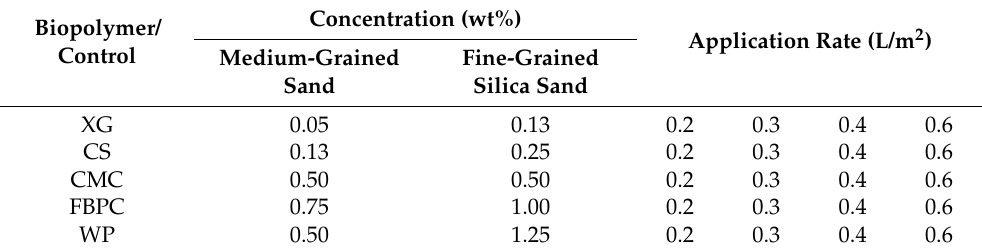
Table 2. Sample program of Phase 2, which tested the effect of the application rate on wind erosion and crust penetration resistance. The biopolymer concentrations were selected based on the results of Phase 1.